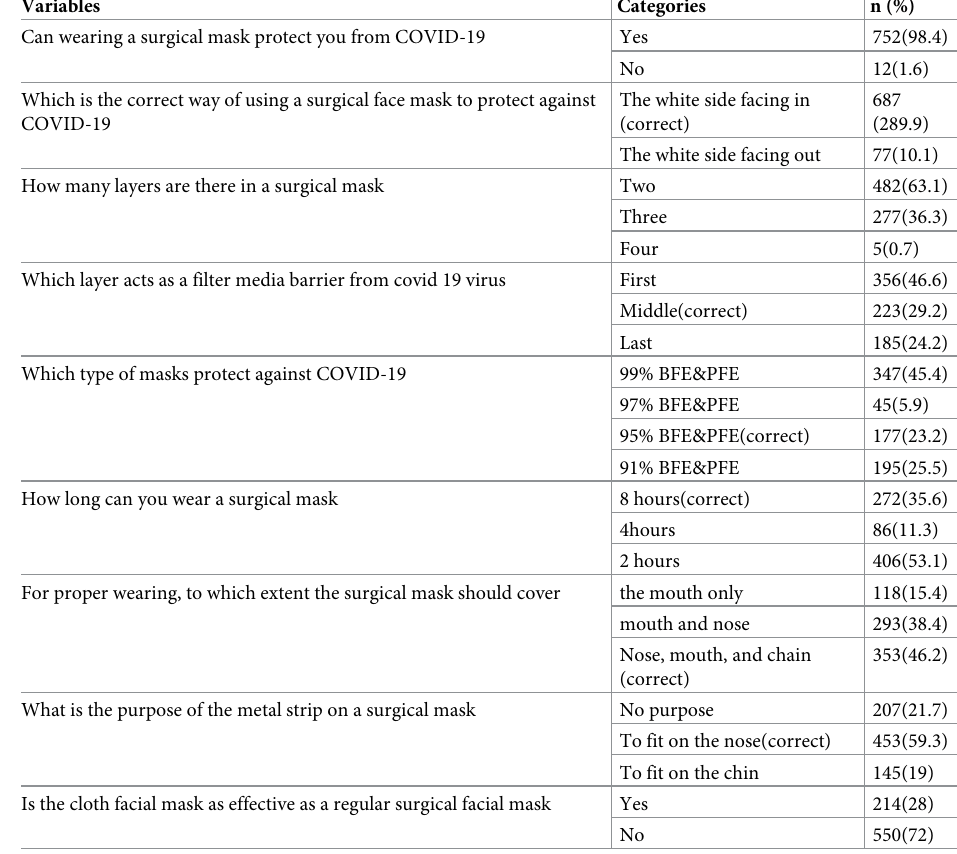
Table 2. Knowledge-related questioner on knowledge, attitudes, and practices of face mask utilization and associ- ated factors in COVID-19 pandemic among Wachemo university students, southern Ethiopia: February to March 2021 (n = 764). Variables Categories n (%) Yes